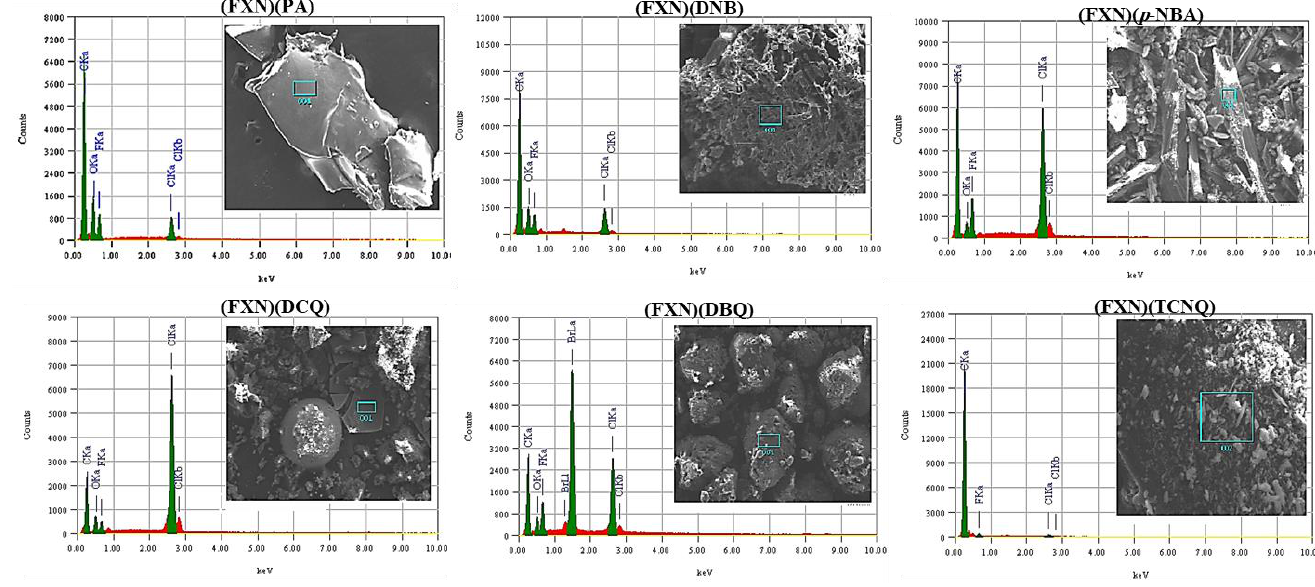
Figure 4. SEM images and EDX spectra of six 1 HNMR spectra of six ligand complexes.